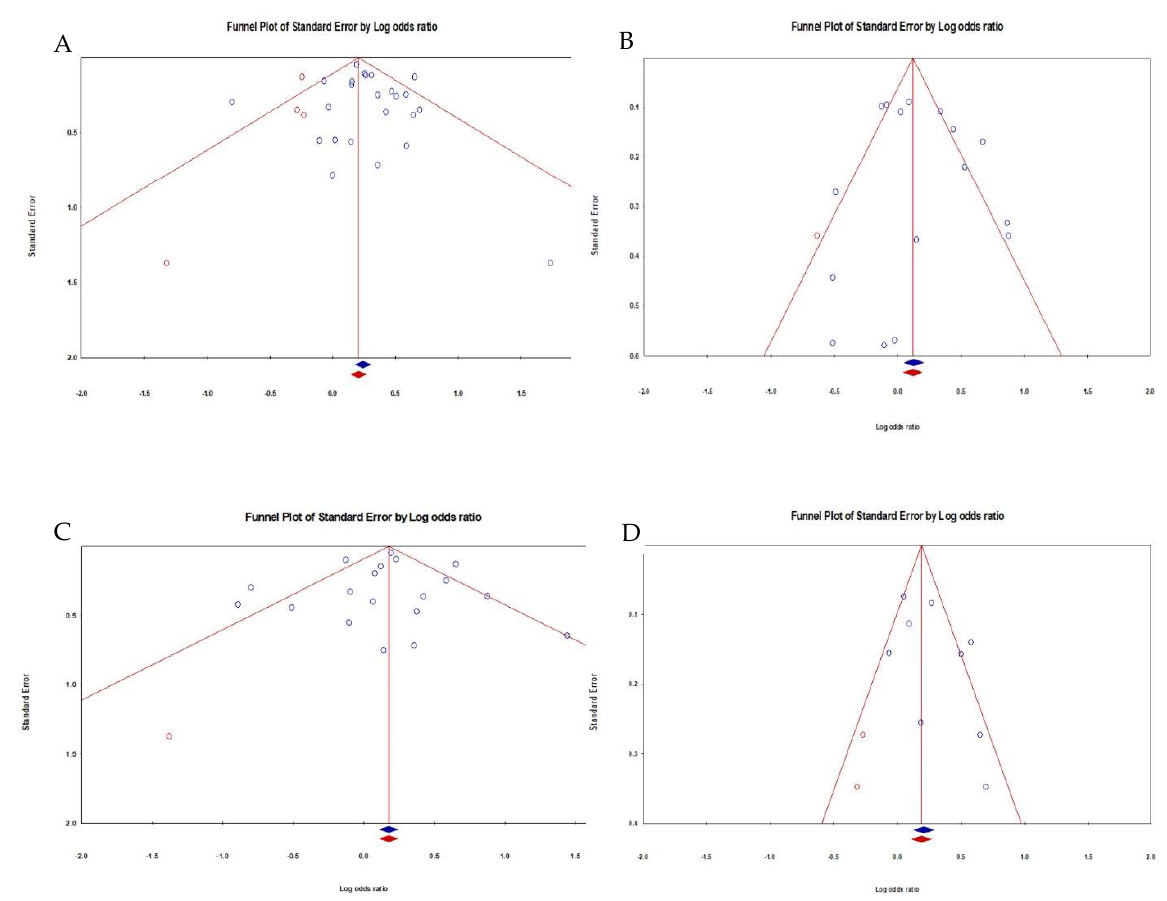
Figure 3. Funnel Plot with imputed studies - Effects of household pesticides on CBT. ( A ) (upper Left) = Before birth; ( B ) (upper right) = After Birth; ( C ) (lower left) = Occupational Exposure; ( D ) (lower right) = Residential. Table 2. Summary results of the statistical procedures for assessing publication biases by pesticide exposure